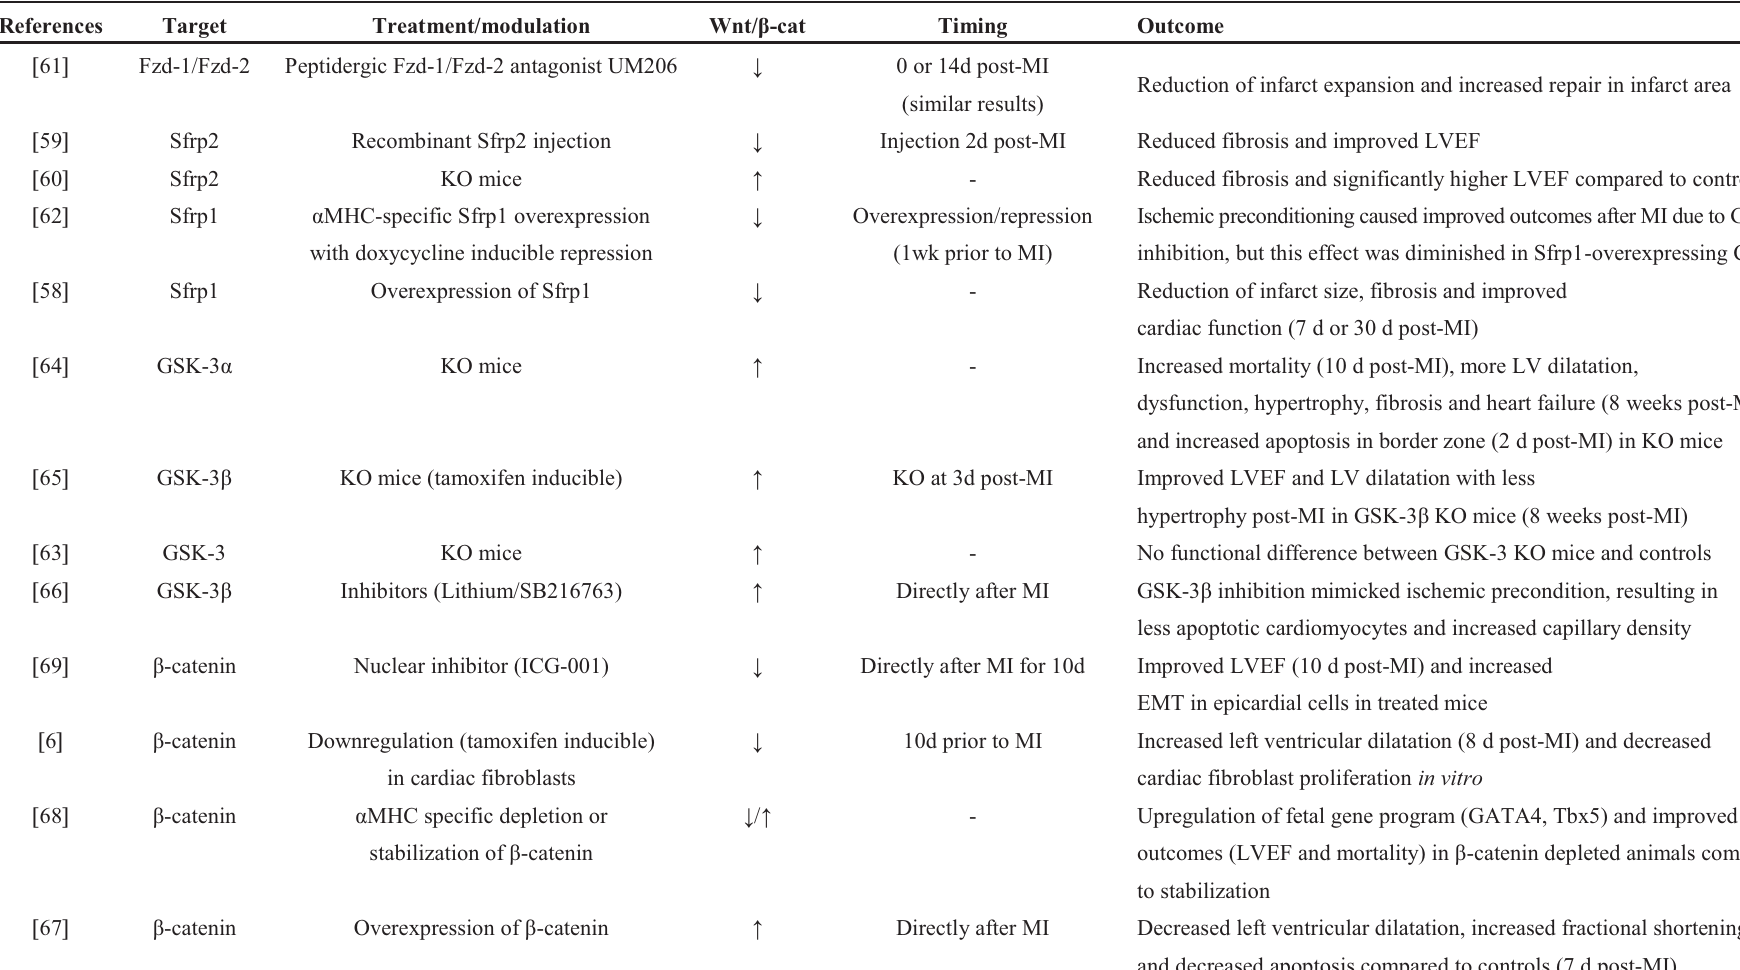
Table 1. Selection of literature on Wnt modulation in cardiac ischemic injury. All studies used a left anterior descending artery (LAD) ligation model in mice or rats. An ischemia-reperfusion model was used in some studies ([62,66]). Fzd = Frizzled. Sfrp = soluble frizzled related protein. GSK = Glycogen Synthase Kinase. KO = knockout. MHC = myosin heavy chain. MI = myocardial infarction. LVEF = left ventricular ejection fraction. CM = cardiomyocytes. LV = left ventricle. EMT = endothelial-to-mesenchymal